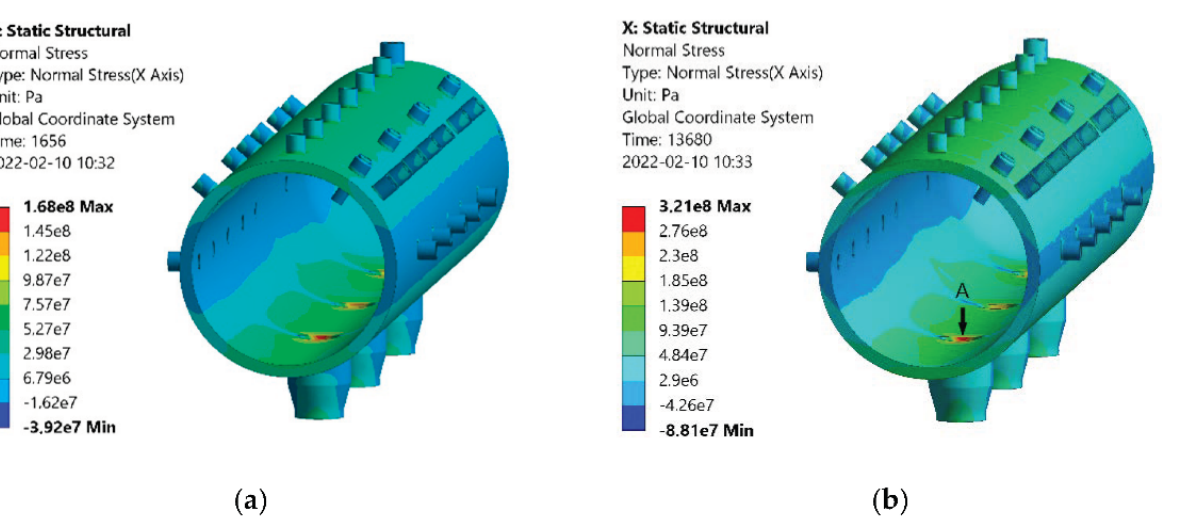
Figure 8. Mechanical parameters of 15NCuMNb steel following 250,000 h of operation, determined from the multilinear kinematic hardening model. ( a ) Temperature-dependent Young’s modulus and ( b ) cyclic stress–plastic strain curves at 293 K and 603 K. Figure 9 illustrates the results of the selected stress and strain calculations. Stress accumulation areas are marked in red. These areas were predicted to accumulate substantial fatigue damage when subjected to frequent startups.